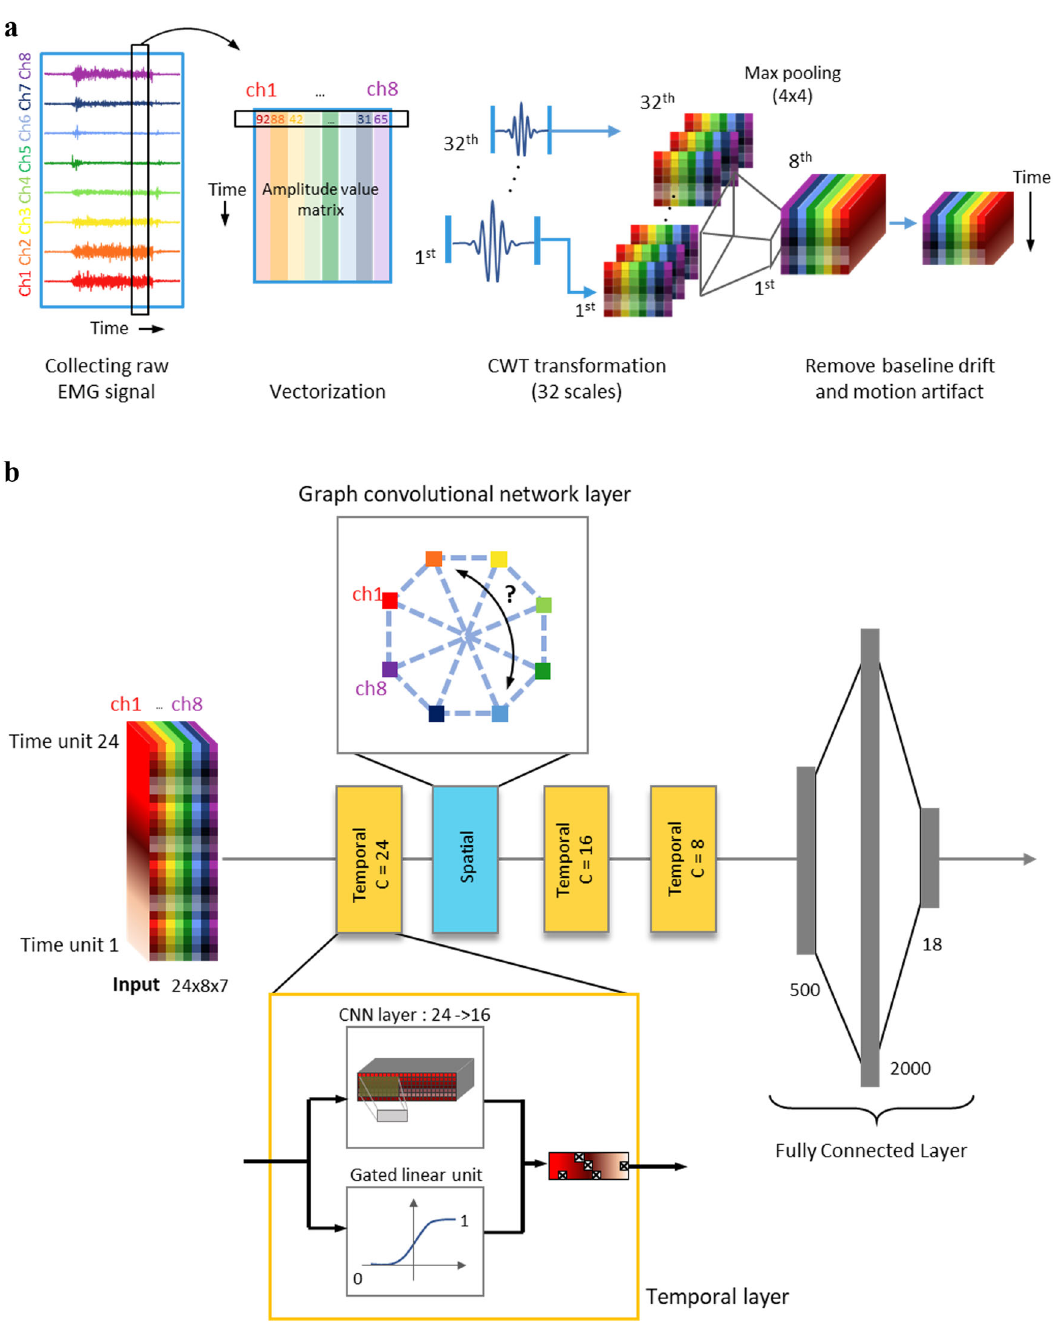
Fig. 3 An illustration of preprocessing multichannel sensor array and graph attention neural networks. a The sensor array is fi rst transformed into a matrix shape (100 × 8). CWT is then applied by selecting 32 scales for every sensor (100 × 32 × 8). Finally, the matrix size is reduced with max pooling and baseline drift for computational ef fi ciency (24 × 7 × 8). b A diagram of graph attention neural networks we used. The preprocessed input data (24 × 8 × 7) get through three temporal blocks and a spatial block followed by three fully connected layers. The temporal block consists of one convolutional neural network layer and a gated linear unit. The fi rst CNN layer translates input dimensions 24 to 16, and the Gated linear unit decided whether the CNN layer ’ s output is usable. Spatial blocks fi lter the output of the temporal block to catch the signal ’ s physical location. Fully connected layers allow the fi nal output to be classi fi ed as 18 relations between non-adjacent sensors. Similarly, GNN-based GNN-based baselines are usually applied to similar domains like approach in sEMG domain can be effectively applied by setting EEG and Biosignals. GNNs are adapted to these domains to the appropriate neighbor relationship. The self-attention allows overcome the limitation of the CNN-based approach, widely our model to adaptively construct the graph data, which sets the applied to classify signal-based data. The limitations of CNNs are appropriate relationships among sensors. The gesture type is a that it identi fi es local (adjacent) spatial patterns due to the small column indicating which type of gesture (dynamic or static) is size of the kernels. However, it is more crucial to identify complex